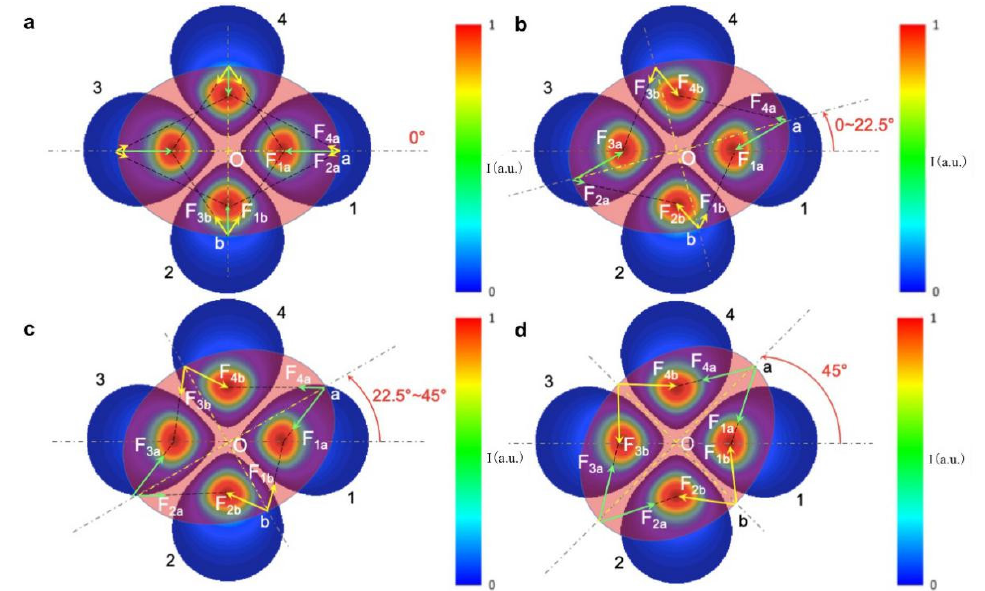
mW and 2  0 = 4.8 μm.